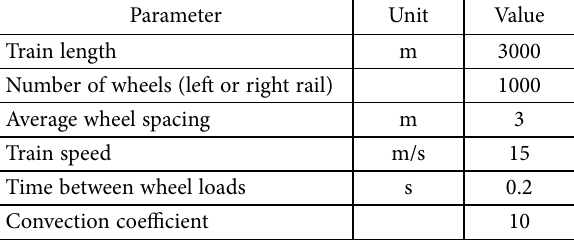
Table 8. Meta-data for time-series bending